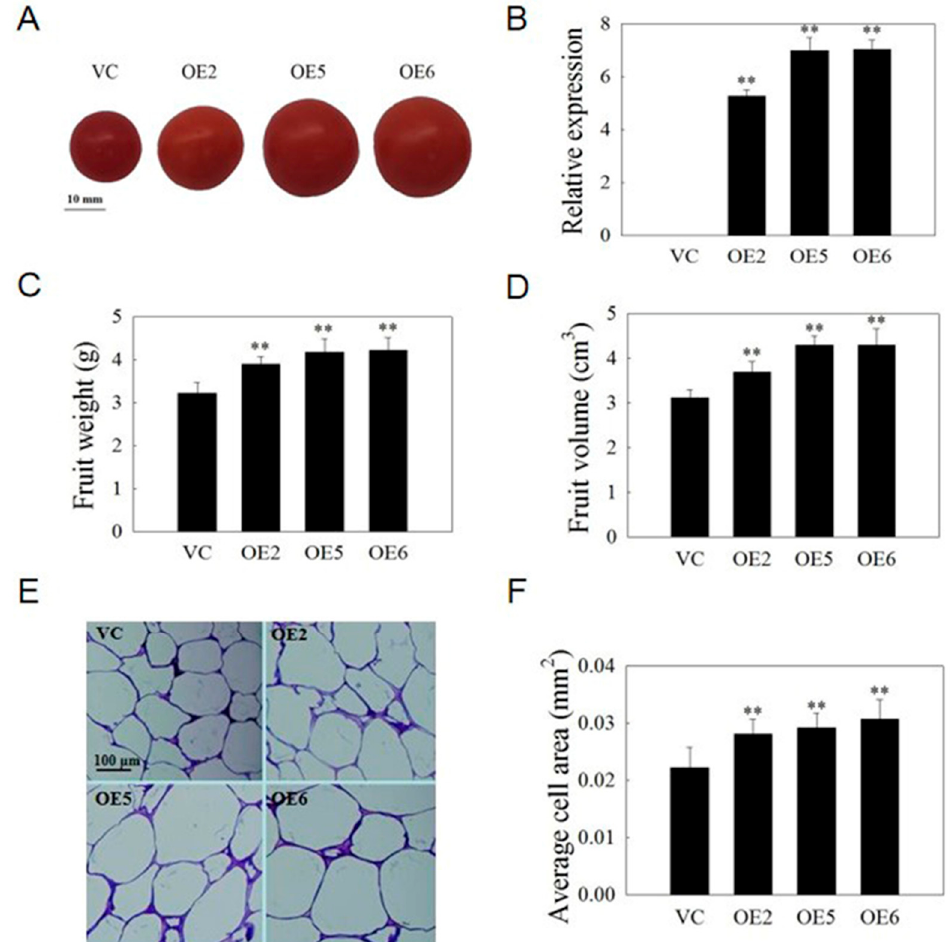
Figure 9. VvSAUR041 plays a positive role in fruit development of tomato. ( A ) Fruit of mature tomato. ( B ) Transcription level of VvSAUR041 in OE and VC transgenic tomato based on RT-qPCR. ( C ) Fruit weight of mature tomato. ( D ) Fruit volume of mature tomato. ( E ) Image of pericarp tissue at mature green stage. ( F ) Average cell area of tomato pericarp. Asterisks indicate a significant difference (** p < 0.01 ).